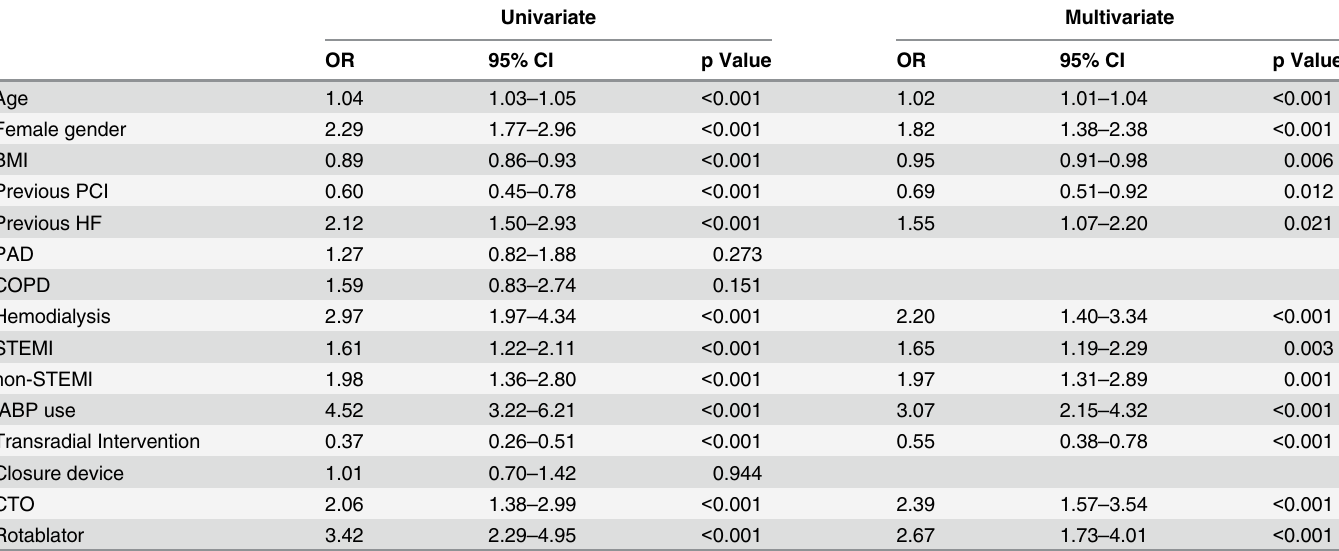
Table 9. Multivariate Logistic Regression Analysis on Bleeding Complications within 72 Hours in Patients without Cardiogenic